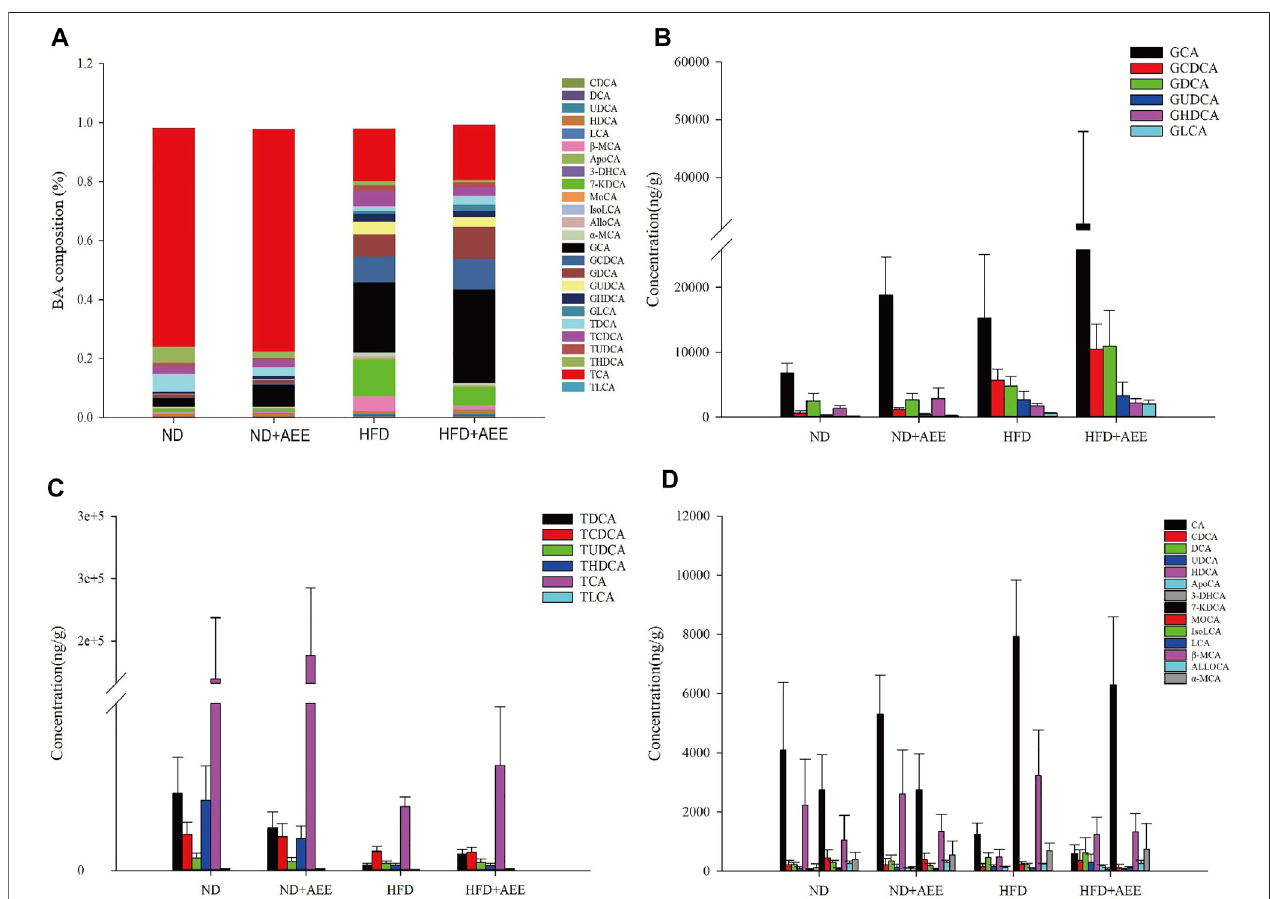
FIGURE 7 | AEE normalized the dysbiosis of BAs composition in hyperlipidemia rats induced by HFD. (A) Liver BA pro fi les are changed after HFD-mediated and AEE treatment. (B) ThechangesofG-BA contentsin ND,ND +AEE, HFD,and HFD +AEE group. (C) The changesofT-BA contentsinND, ND+AEE, HFD,and HFD + AEE group. (D) The changes of unconjugated BAs in ND, ND + AEE, HFD, and HFD + AEE group. ND, control diet; HFD, high-fat diet; AEE, aspirin eugenol ester.